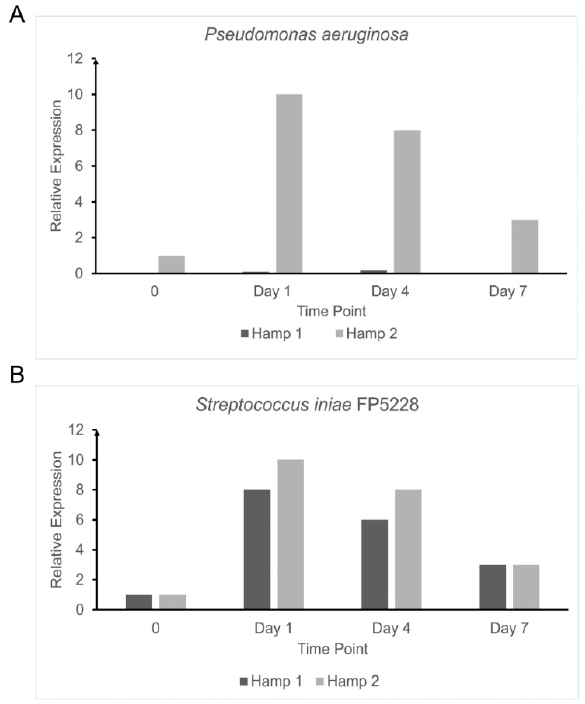
Figure 5. Black rockfish ( A ) hepcidin (Hamp1 and Hamp2) expression in the liver after iron overload and ( B ) Ferroportin 1 (FPN1) expression in the liver and intestine under experimental iron overload. ( C ) Transferrin receptor 1 (TFR1), expression in the liver and intestine under experimental iron overload. ( D ) Ferritin (FTN) expression in the liver and intestine under experimental iron overload. Fish were injected with 2 mg of iron dextran (n = 4). Values are expressed as mean fold change ± SD. β‐ Actin was used as the housekeeping gene.